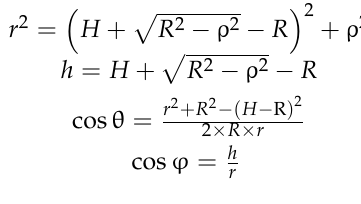
position/height position/height ratio.